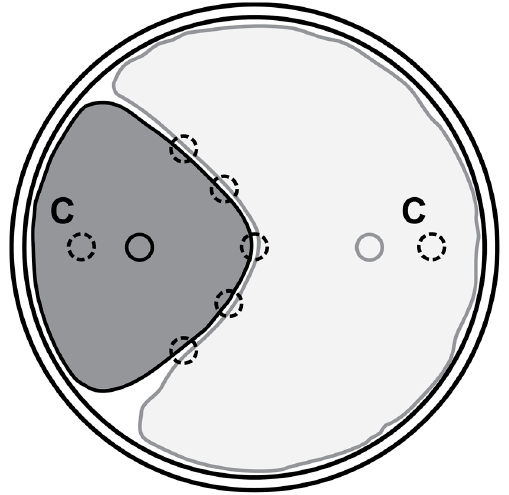
Figure 1. Design of the re-isolation test from a Petri dish with competing mycelia: Five discs taken from the interaction zone and two control discs (C) from the colony margins. The gray culture is the response isolate of E. parasitica , and the white culture is the challenge isolate (illustration by S. Zidar, Slovenian Forestry Institute).